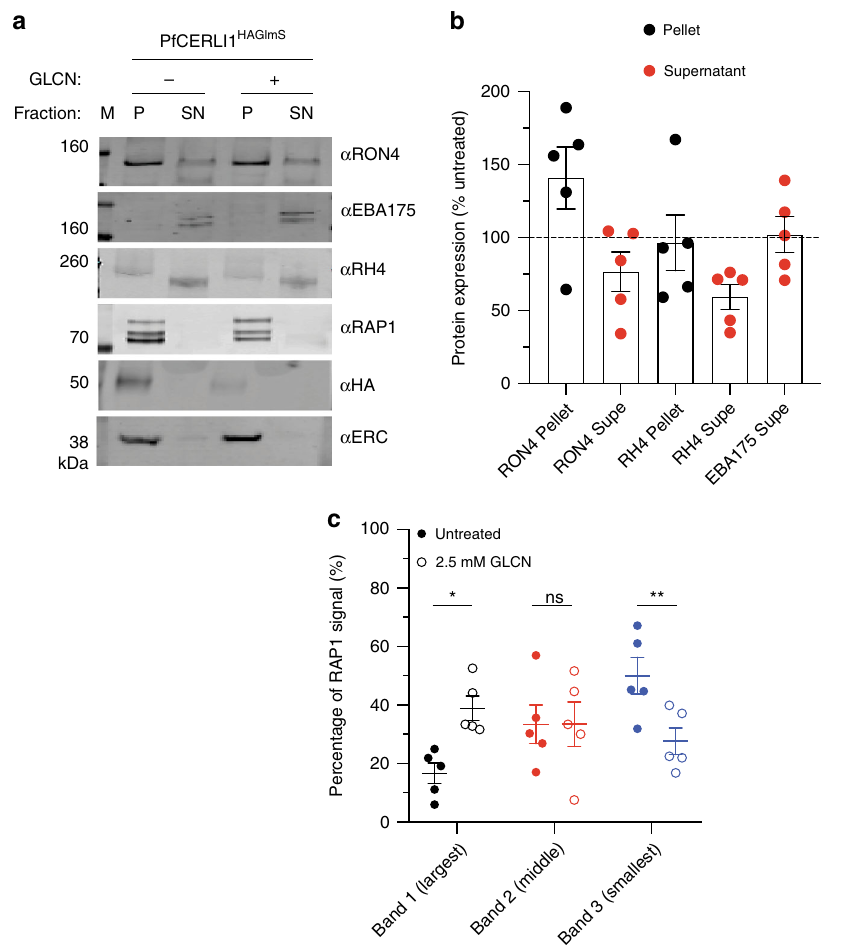
Fig. 6 PfCERLI1 HAGlmS knockdown alters rhoptry antigen processing and secretion. a PfCERLI1 HAGlmS parasites were either treated with 2.5 mM GLCN ( + ) or left untreated ( − ), with the erythrocyte surface receptors of the culture cleaved by enzyme treatment to prevent invasion but allow release of merozoite antigens. The parasite lysate (P) and culture supernatant (SN) were stained with anti-RON4 (rhoptry neck), anti-EBA175 (micronemes), anti- RH4 (rhoptry neck), anti-RAP1 (rhoptry bulb), anti-HA (PfCERLI1) and anti-ERC (loading control) antibodies and analysed by western blot. Selected blots representative of fi ve independent experiments (M = size markers). b Western blots of rhoptry antigens, and secreted EBA175, were normalised to the loading control (ERC) and quanti fi ed, with data represented as + 2.5 mM GLCN signal expressed as a % of the signal for the untreated control ( n = 5 biological replicates, source data are provided as a source data fi le). c Using the parasite lysates from the rhoptry secretion experiment, each of the three individual RAP1 bands present on the western blots were quanti fi ed and presented as a percentage of the total RAP1 signal ( n = 5 biological replicates, ns = p > 0.05, * p < 0.05, ** p < 0.01 by two-way ANOVA). All error bars =